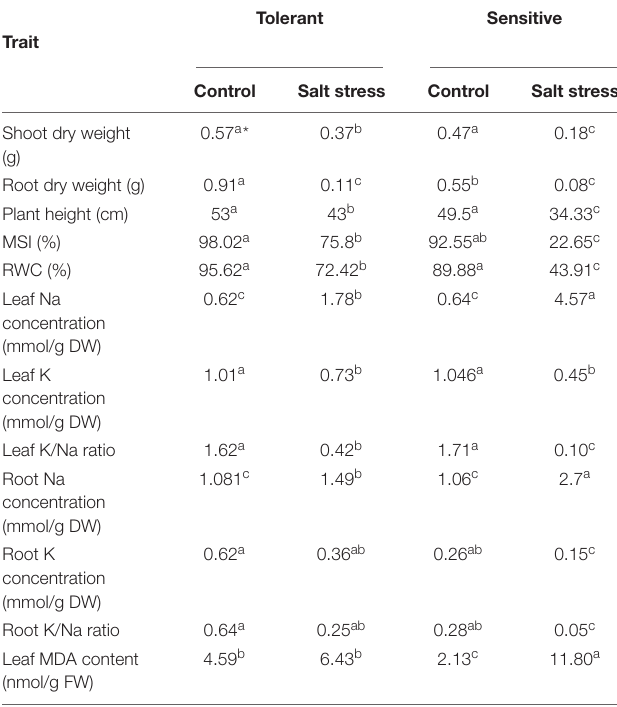
TABLE 1 | Mean comparisons of tolerant and sensitive barleys for growth and physiological traits in control and salt stress conditions. Tolerant Trait